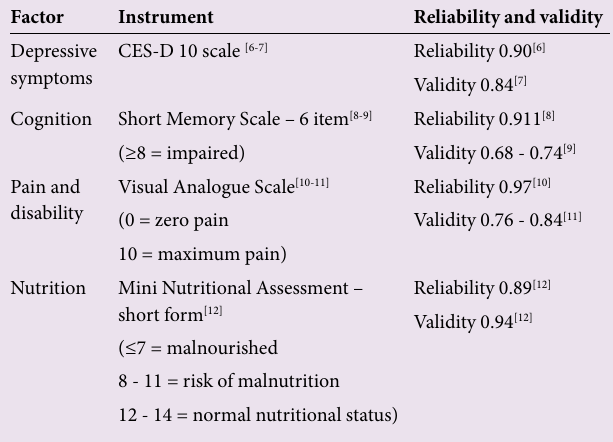
Table 1. Instruments used in study